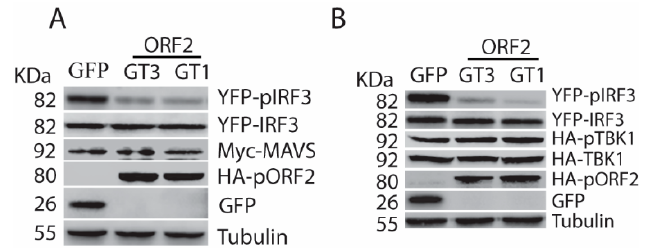
Figure 3. The capsid protein inhibits IFN induction by blocking TBK1-mediated IRF3 phosphorylation. ( A ) The capsid protein of HEV GT1 and GT3 blocks MAVS-induced IRF3 activation. The HEK293T cells were co-transfected with ORF2, IRF3, and MAVS plasmids. The cells were harvested at 24 h later for WB. The molecular weights of the proteins are indicated on the left. ( B ) The capsid protein blocks TBK1-induced IRF3 activation. The HEK293T cells were co-transfected with ORF2, IRF3, and TBK1. Transfection and WB were conducted as described in “A” above.